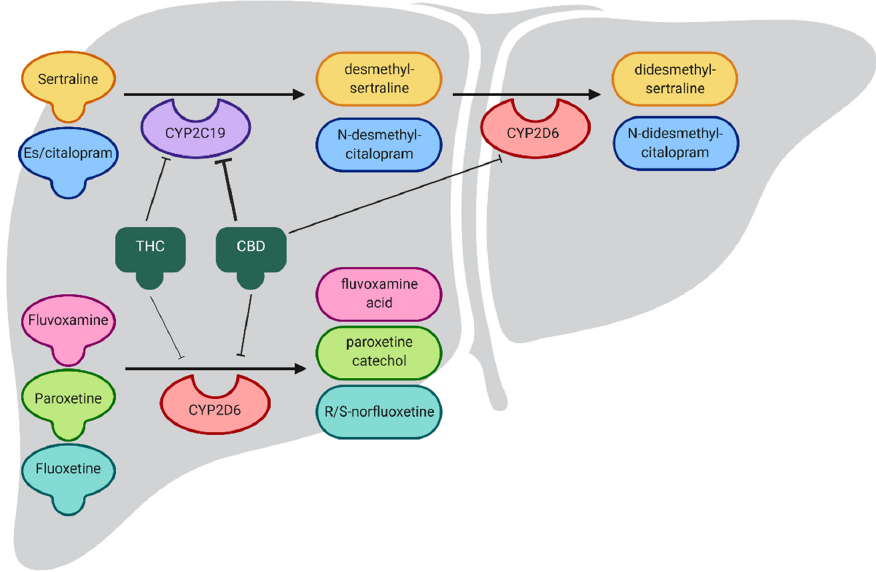
Figure 1. SSRI metabolism and the effects of cannabidiol (CBD) and tetrahydrocannabinol (THC) on CYP2C19 and CYP2D6 activity. Both CBD and THC inhibit CYP2C19, decreasing the metabolism of CYP2C19 substrates, including sertraline and es/citalopram, delaying production of active metabolites. THC and CBD have a reduced effect on CYP2D6, indicated by the thickness of the lines showing inhibition.